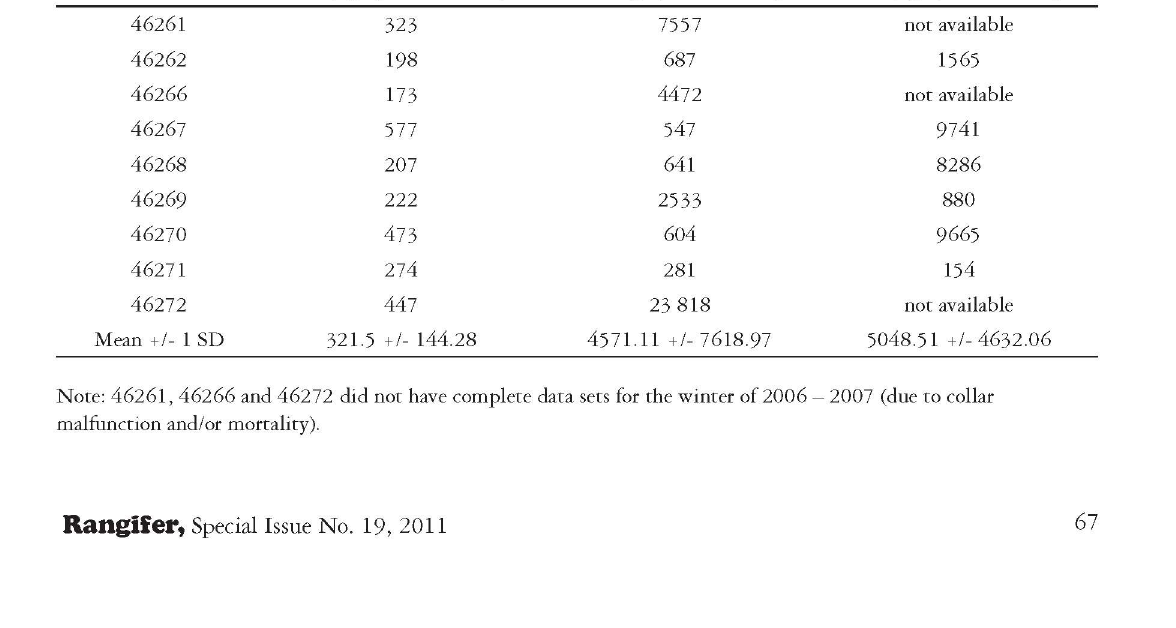
Table 3- Distance between calving and over-wintering ranges. Caribou # Distance between calving range 2005 and